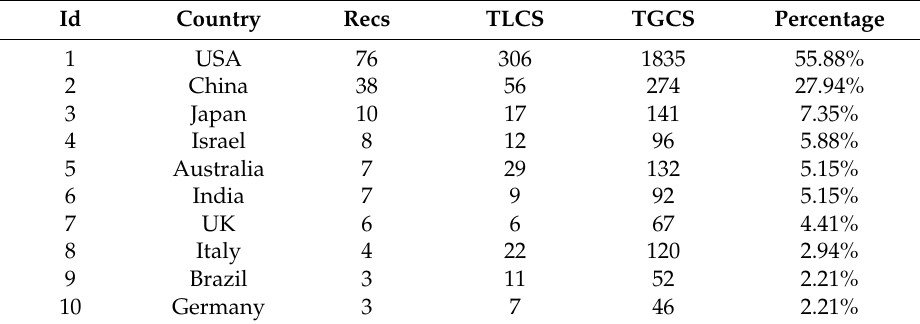
Table 2. Top ten productive countries studying the NTL remote